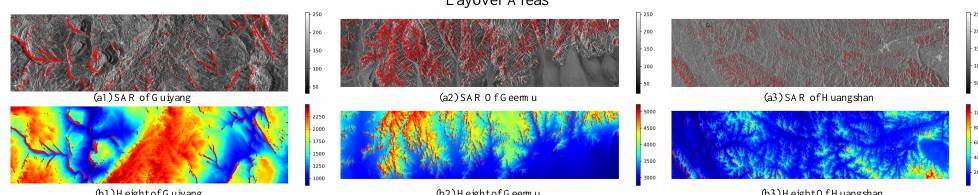
Figure 14. Layover areas are marked as red points in three